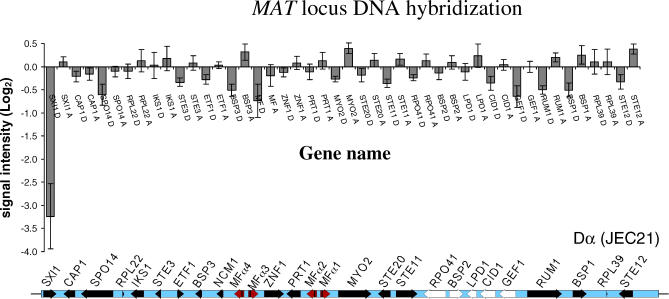
CGH of the αADα Hybrid Mating Type LocusFragmented genomic DNA from the environmental isolate 6–20 and a mixture of genomic DNA from strains H99 (Aα) and JEC21 (Dα) was labeled with fluorescent dyes and competitively hybridized to a 70-mer genomic array. The fluorescent signal level was normalized across the genome, and the average of six independent replicates of the fluorescent intensity ratio for the serotype A and D MAT locus α alleles is shown. Error bars represent the standard deviation. “A” or “D” at the end of each gene name indicates the serotype A– or serotype D–specific allele. A schematic representation of the mating type locus is illustrated below. Blue indicates intergenic regions, red indicates the pheromone gene cluster, and white indicates highly conserved genes [74].